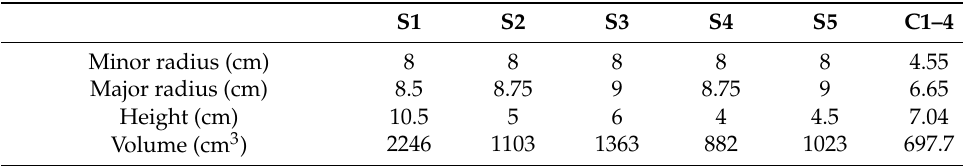
Table 5. Pot characteristics.